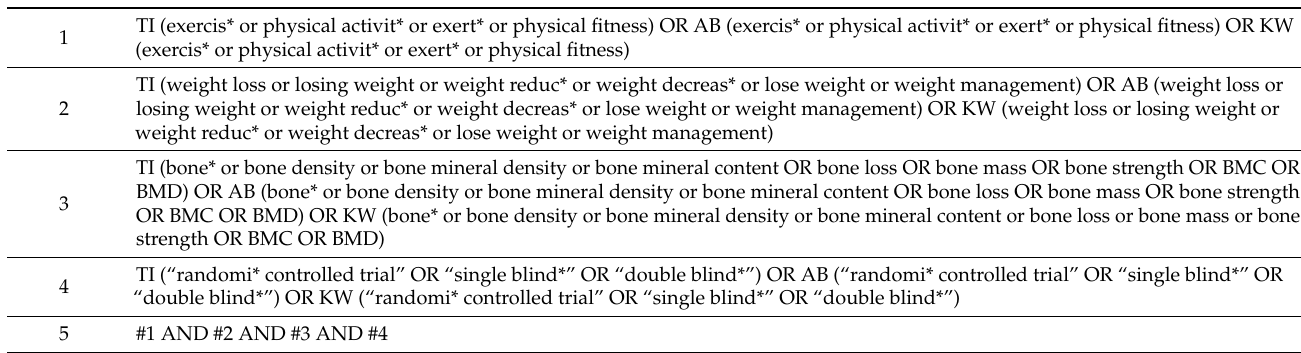
Table A2. SportDiscus in EbscoHost search